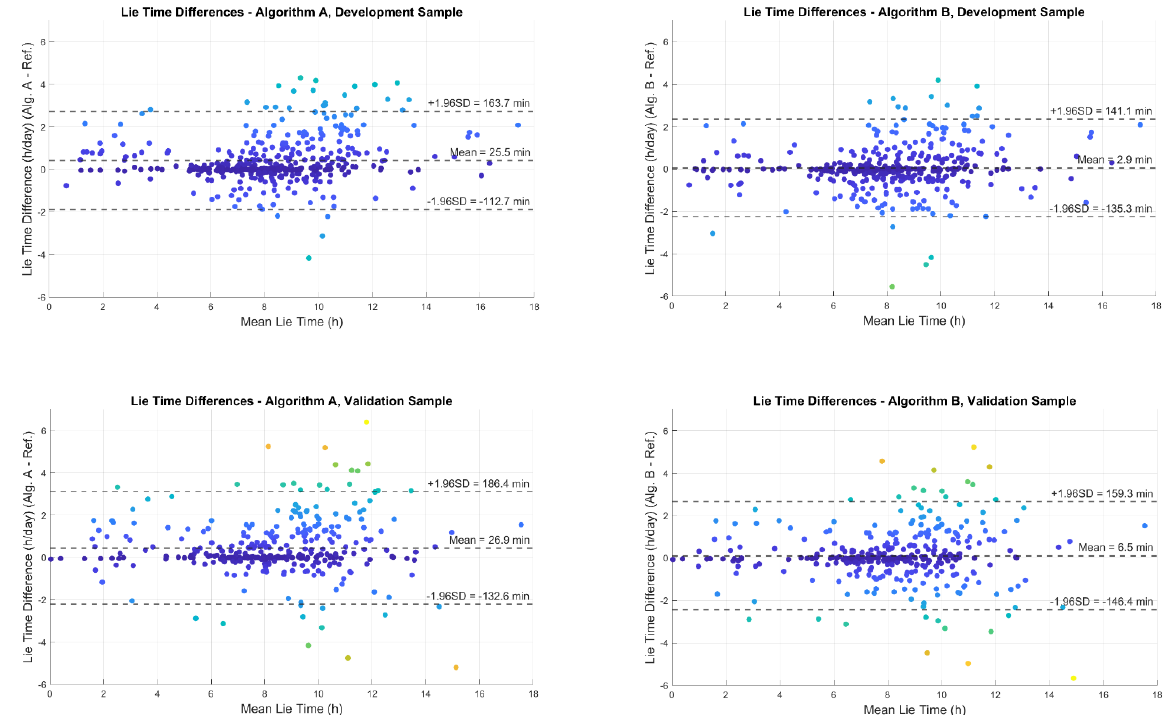
Figure 4. Bland Altman plots showing the difference in estimation of lying down time per day between the reference method and the two algorithms A and B. Each dot in the plots represent a measured day. The mean value of lying time by the reference method and each algorithm is given in x -axis. The difference between lying time detected by each algorithm and the reference method is given in y -axis.